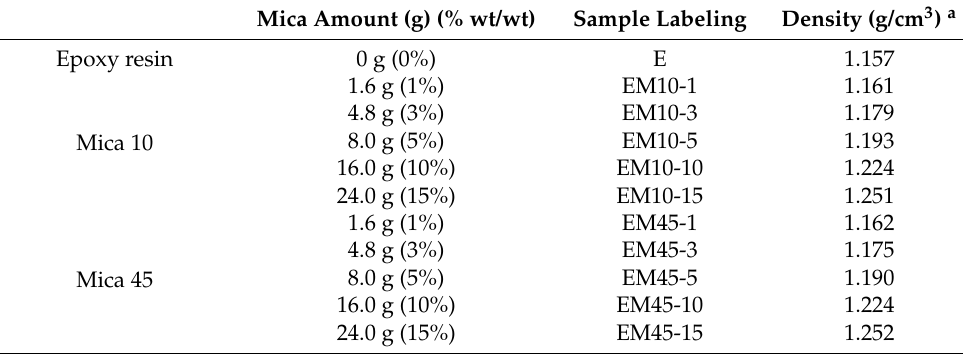
Table 1. Experimental details for nanocomposite preparation and labeling.